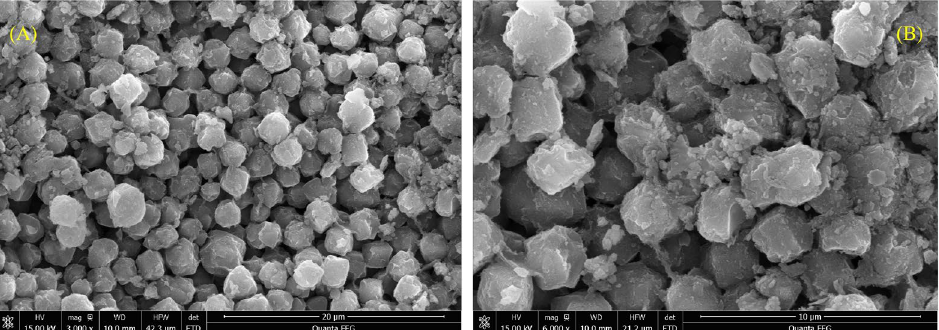
Figure 4. SEM image of ZC at different magnifications: ( A ) 3000×, ( B ) 6000×.